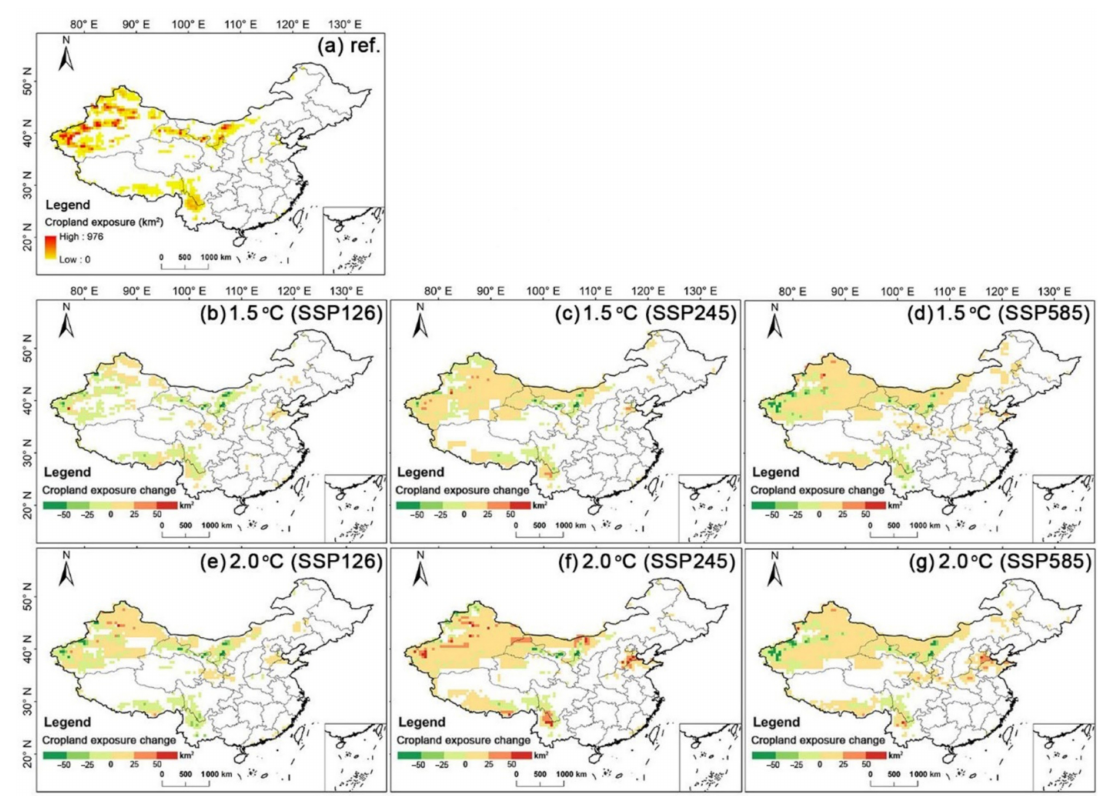
Figure 6. Spatial distributions of the cropland exposure to droughts in the reference period ( a ), the